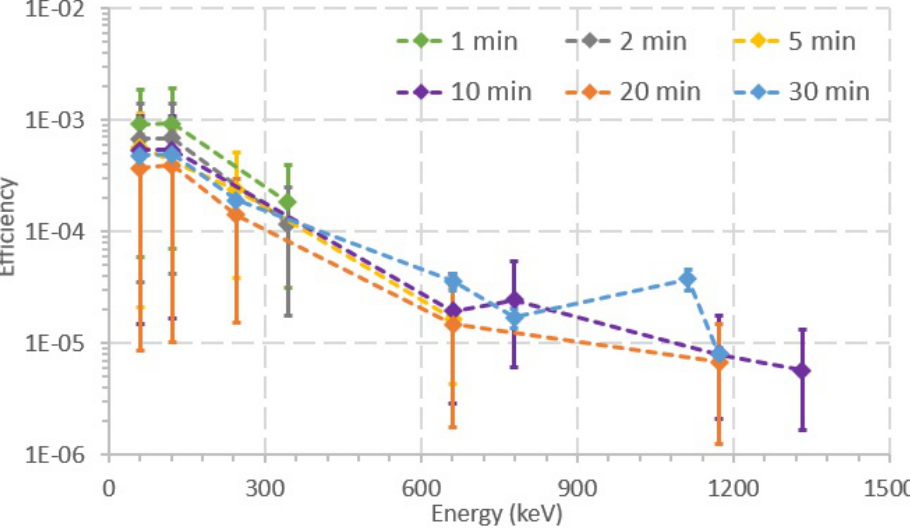
Figure 8. Efficiency of the photopeaks observed at different acquisition times, with the same geometry used in the calibration. Lines and markers of different colors represent peak efficiencies with different acquisition times, ranging between 1 and 30